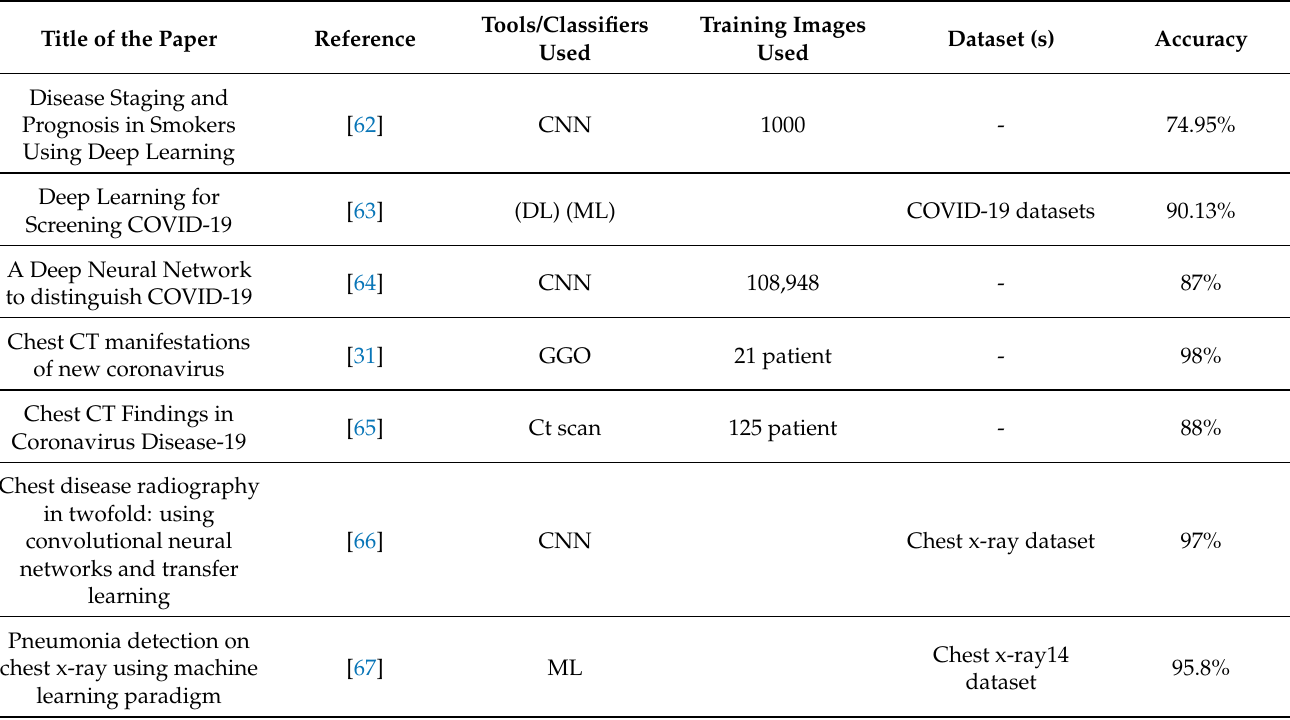
Table 1. Summary of recent studies on the detection of chest-related diseases.